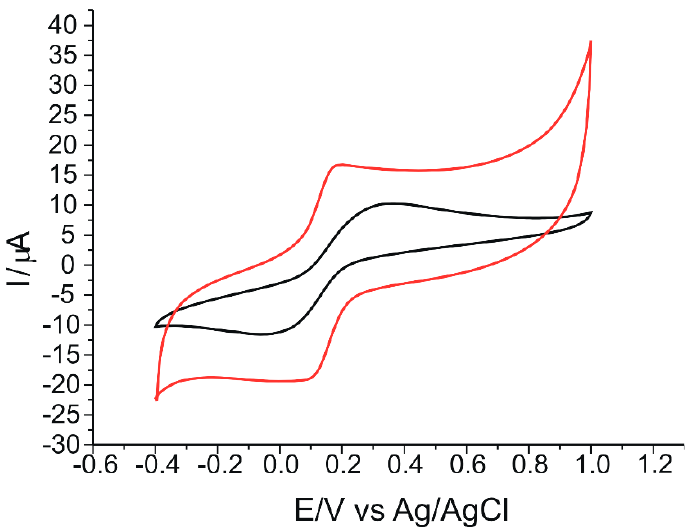
Figure 6. CVs of SPCE/GPHOX (black line) and SPCE/GPHOX-Pentapeptide (red line) immersed in 10 − 3 M K 4 [Fe(CN) 6 ]/K 3 [Fe(CN) 6 ]–0.1 M PBS solution, at the scan rate of 0.05 V·s − 1 .